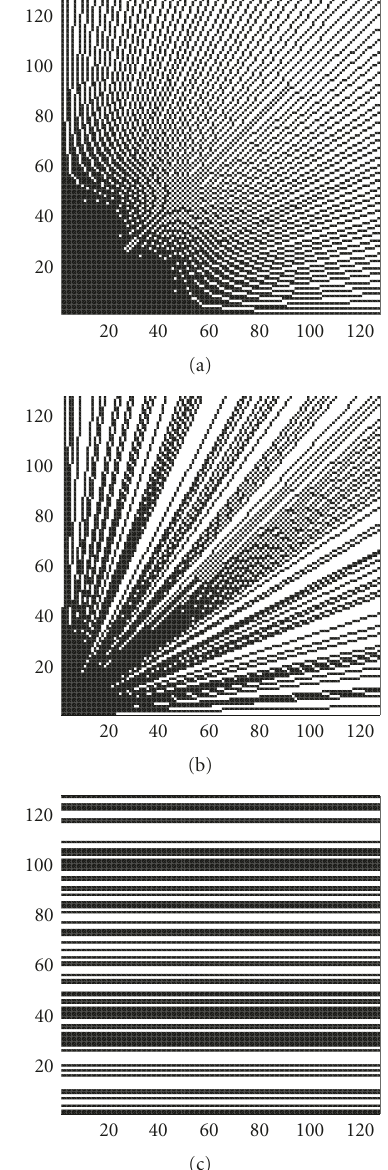
Figure 2: Di ff erent sampling patterns with a comparable number of samples: (a) equispaced radial lines. (b) Random radial lines. (c) Uniform random horizontal